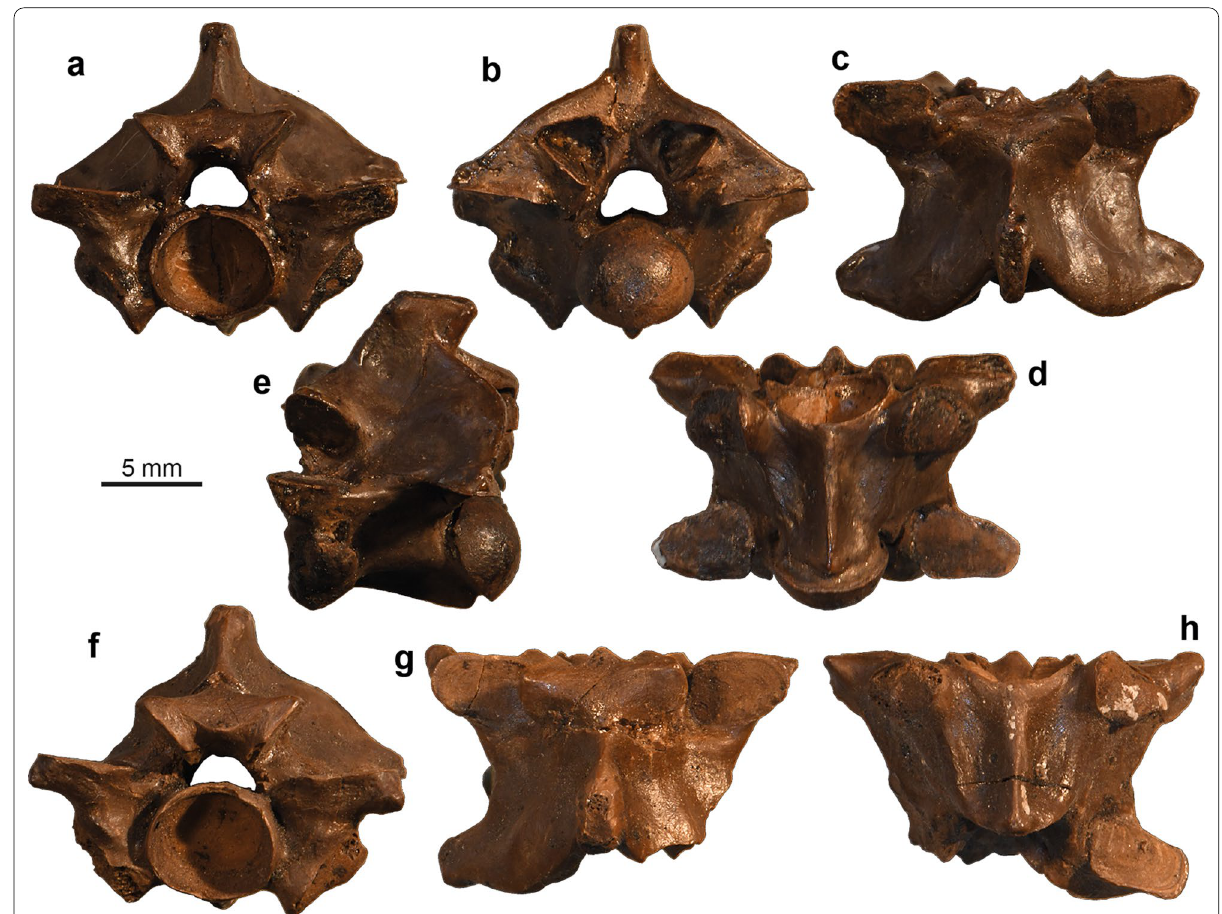
Fig. 57 Eoconstrictor cf. fischeri from quarry XXII, Geiseltal: a – e mid-trunk vertebra (GMH XXII-Y-43a) in anterior ( a ), posterior ( b ), dorsal ( c ), ventral ( d ), and left lateral ( e ) views; f – h mid-trunk vertebra (GMH XXII-Y-43b) in anterior ( f ), dorsal ( g ), and ventral ( h )